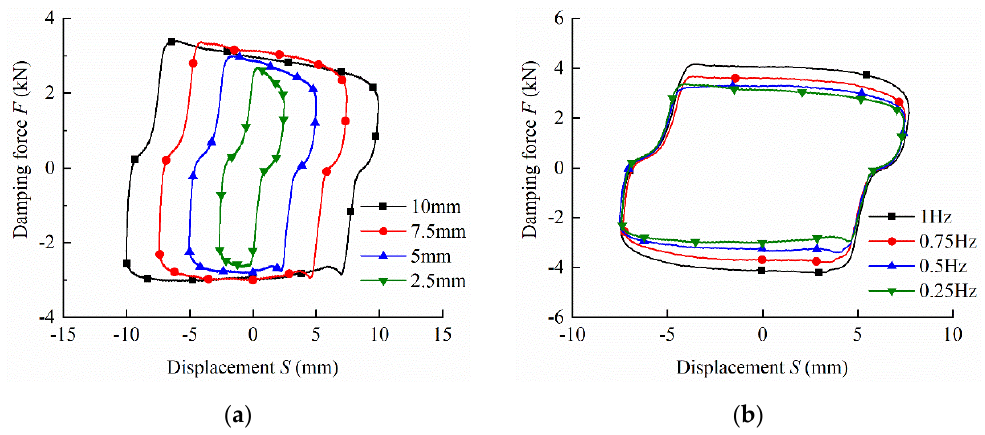
Figure 14. Damping force under different amplitudes and frequencies: ( a ) Damping force under different amplitudes; ( b ) Damping force under different frequencies.